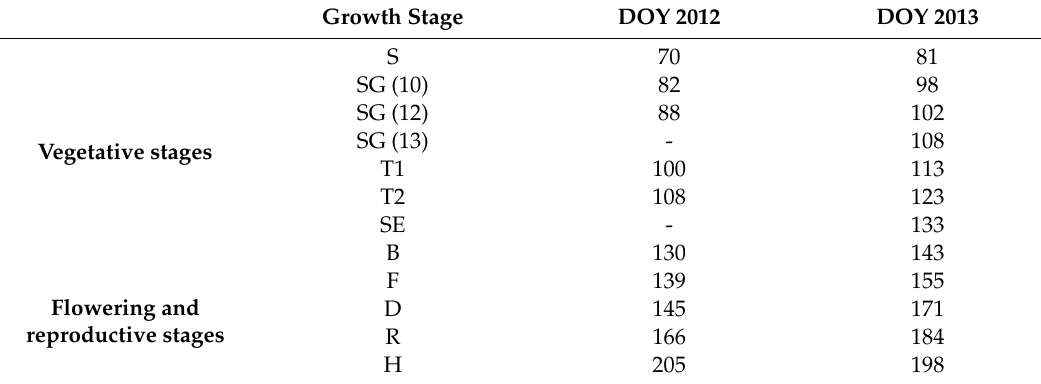
Table 1. Day of year (DOY) of vegetative and reproductive stages based on Zadoks’s scale [62].